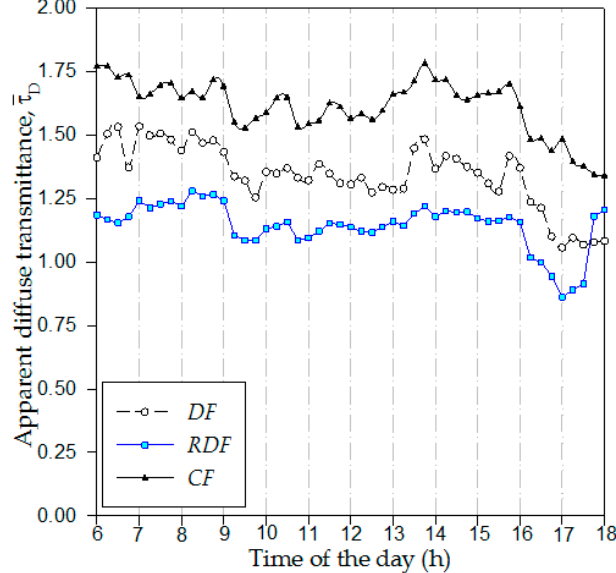
Figure 8. The diurnal variations of the apparent transmittances ( τ D ) were estimated for the three films covered greenhouses (the diffusive, DF , reflective-diffusive , RDF, and control, CF ) on a sunny day (30 September 2019).